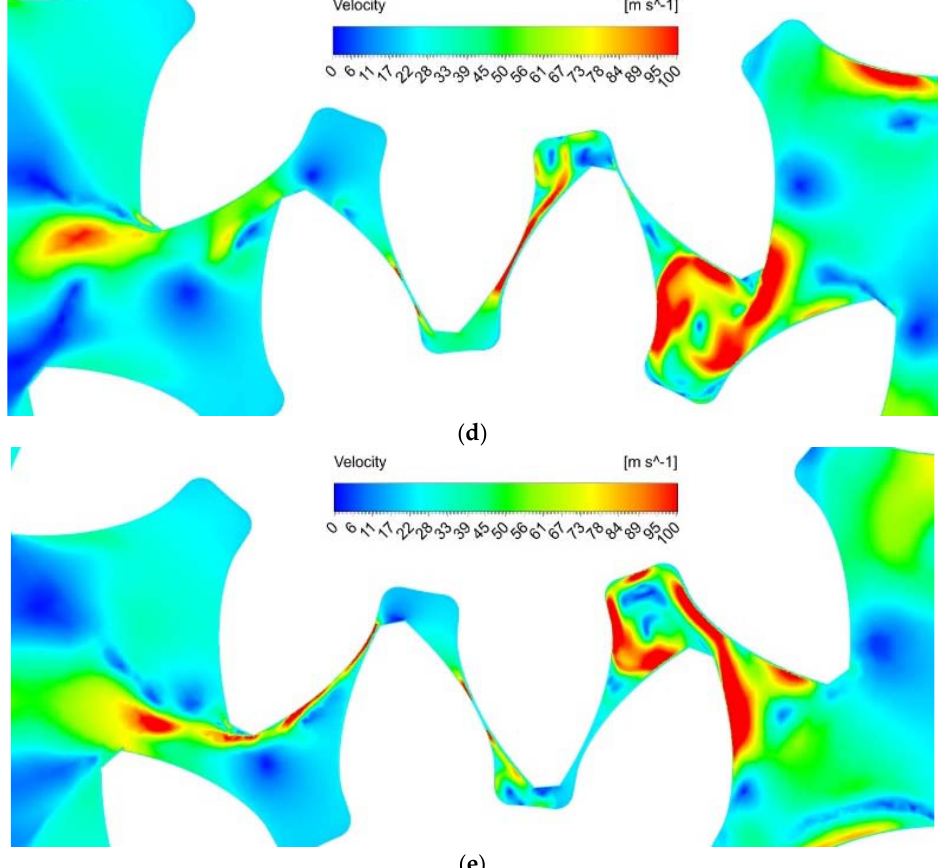
Figure 12. Velocity distribution for fuel pump (( a – e ) in accordance with the position in Figure 10) a = 0.0002 s, b = 0.00038 s, c = 0.00045 s, d = 0.0005 s, e = 0.00065 s.